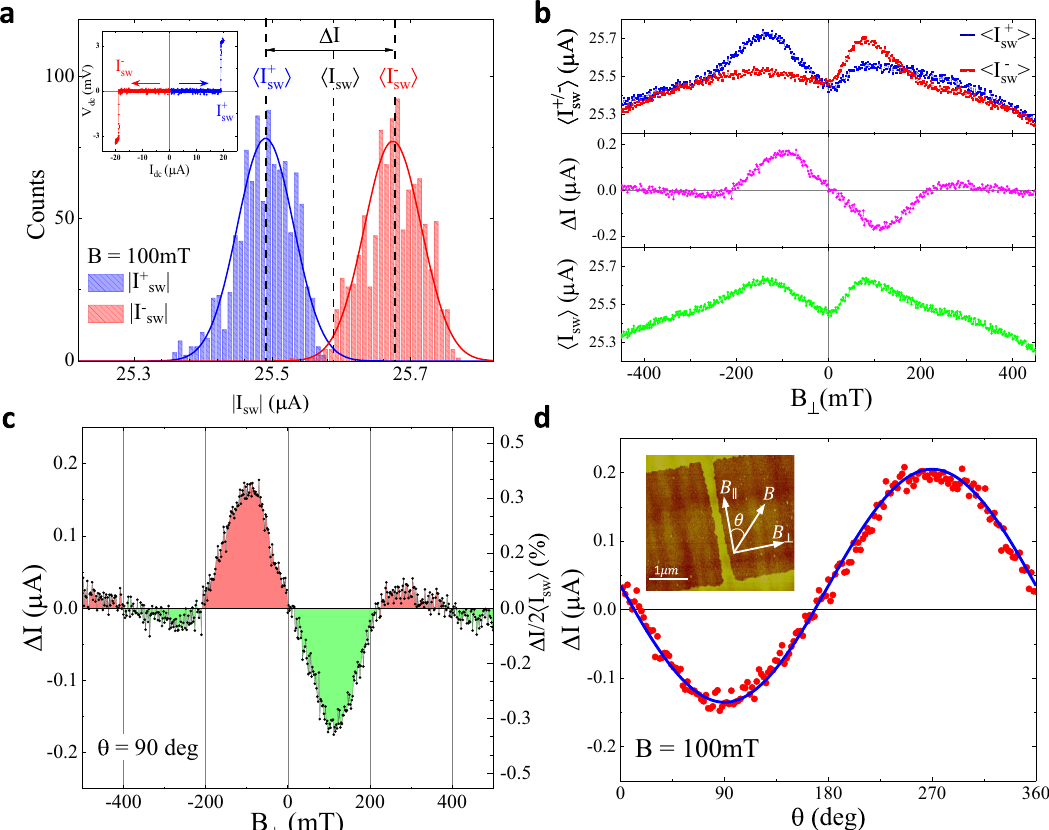
Fig. 1 | Nonreciprocal critical current in Al/InAs nanowires. a Histograms of switching currents for 10,000 positive I + sw and negative I (cid:1) sw current sweeps per- formed at T =30 mK and B ⊥ =100 mT. Inset shows a typical current-voltage char- acteristic. b Average switching current for positive h I + sw i and negative h I (cid:1) sw i sweeps, non-reciprocaldifference Δ I = h I + sw i(cid:1) h I (cid:1) sw i andanaverageofallsweeps 〈 I sw 〉 isplotted